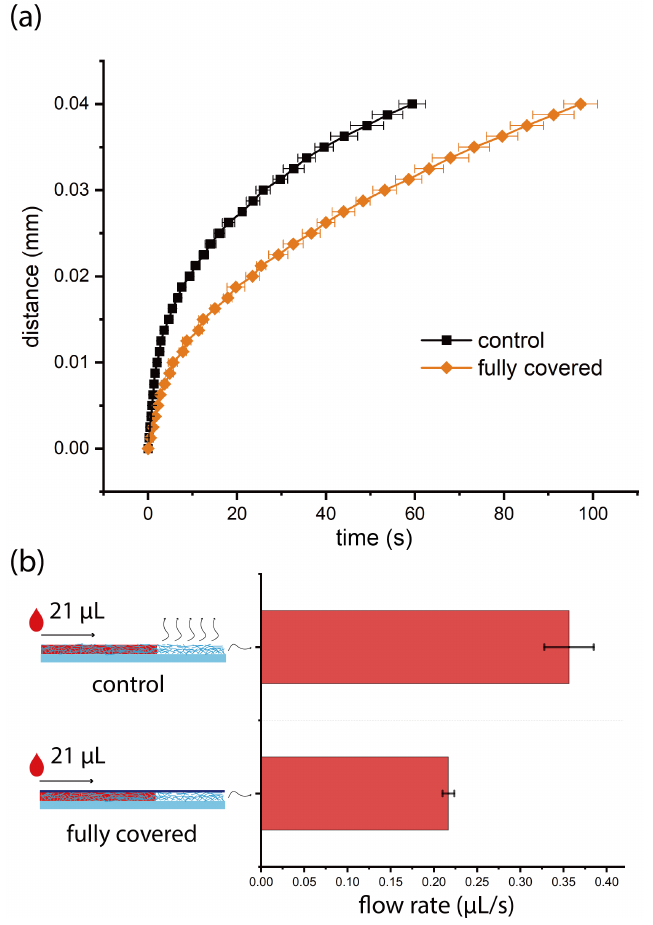
Figure 2. The flow behavior of DI water with red color dye on nitrocellulose test strips with or without tape. ( a ) is the time-distance plot: black solid dots are from the control group, and the orange solid dots are from the group of surface fully covered by tape. ( b ) shows the average flow rates: the left shows the schematic of liquid imbibition in nitrocellulose test strips with or without tape, the curvy arrows indicate the air propelled out from nitrocellulose, the right shows the comparison of average flow rates. On nitrocellulose test strips, every experiment is repeated three